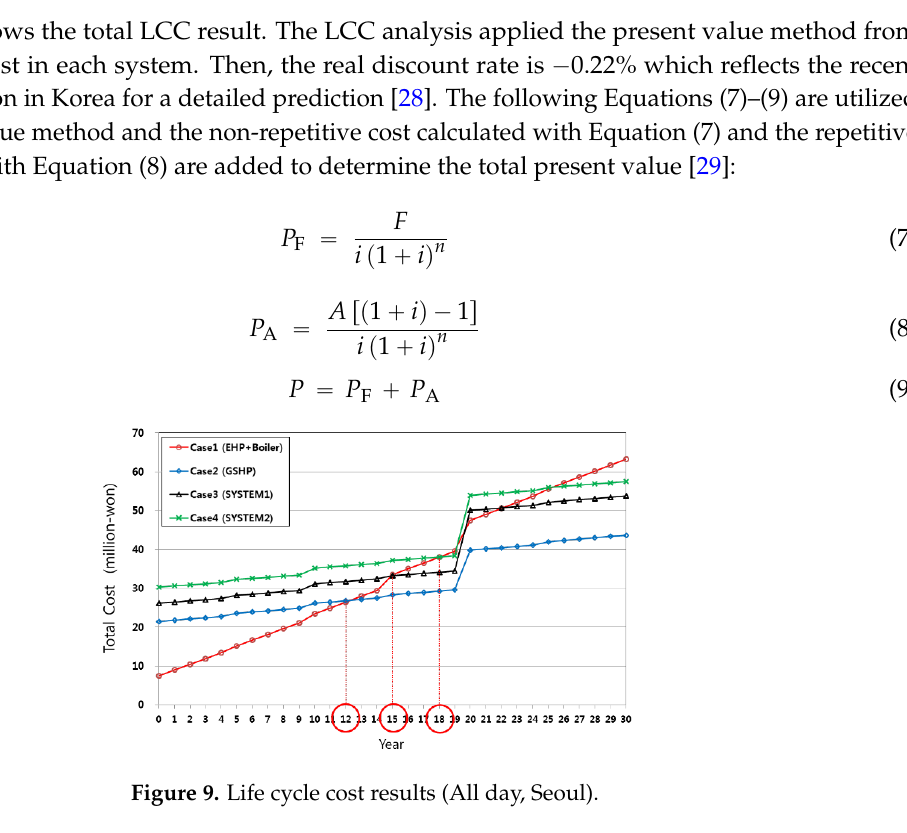
( B ) Figure 10. Operation cost calculation according to five different climate locations. ( A ) Day; ( B ) Night.